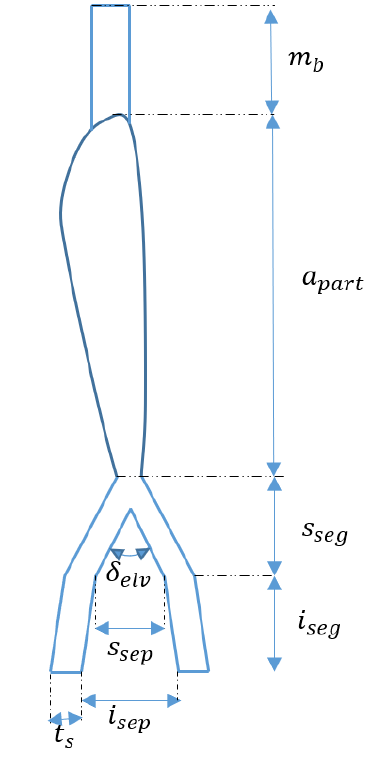
Figure 7. Motor support scheme.